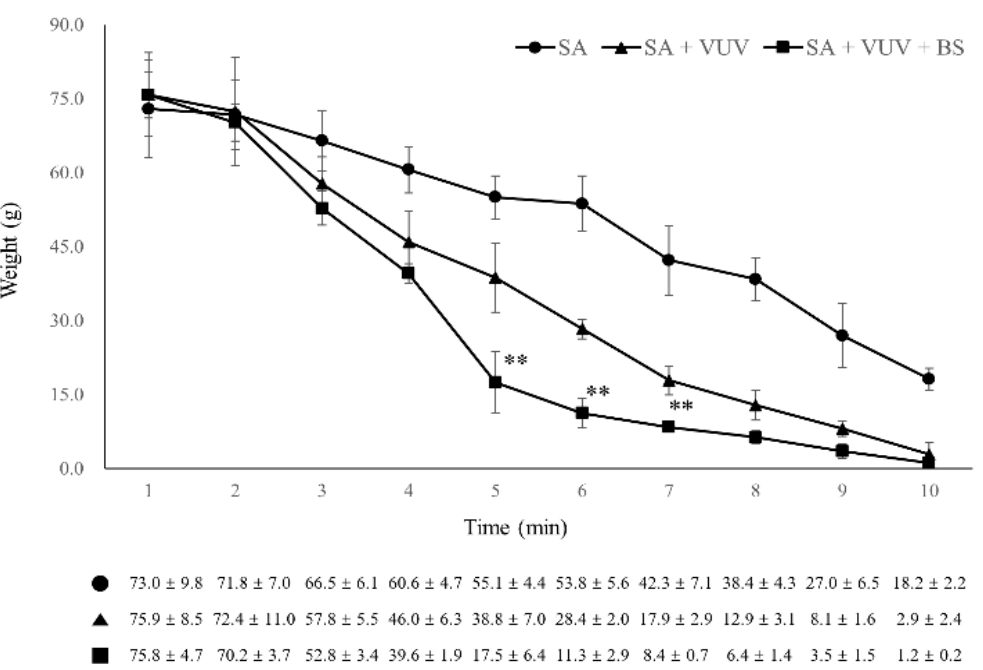
Figure 6. In vivo test of blood clotting. Weight (g) of the whole blood absorbed in the cotton pellet measured from each implant site according to time. SA, a conventional SA surface; SA + VUV, an SA surface with vacuum-UV treatment; SA + VUV + BS, an SA surface coated with a pH-buffering agent after vacuum-UV treatment. Mean ± SD, ** p < 0.01 by Kruskal–Wallis test. Table 1. Summary Statistics of this Study.